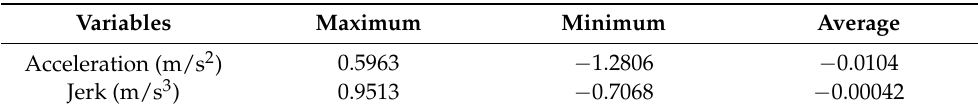
Table 3. Statistics of the acceleration and jerk of the host vehicle with cut-in recognition under driving scenario 3.